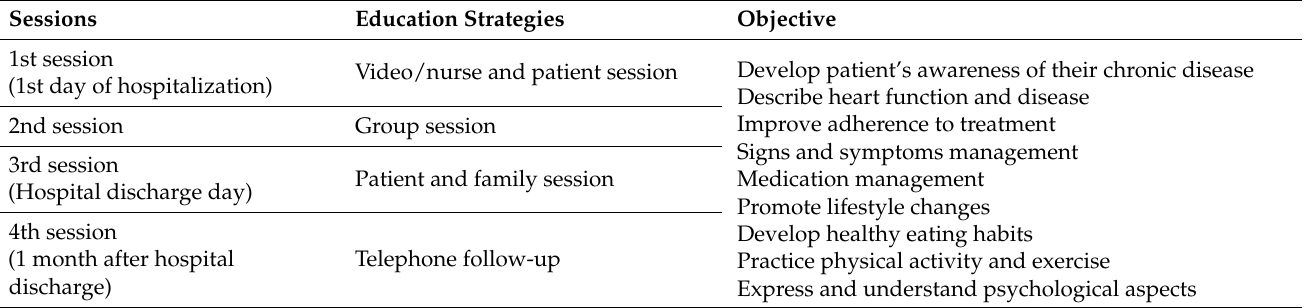
Table 2. Sessions developed during the educational intervention program for patients with acute coronary